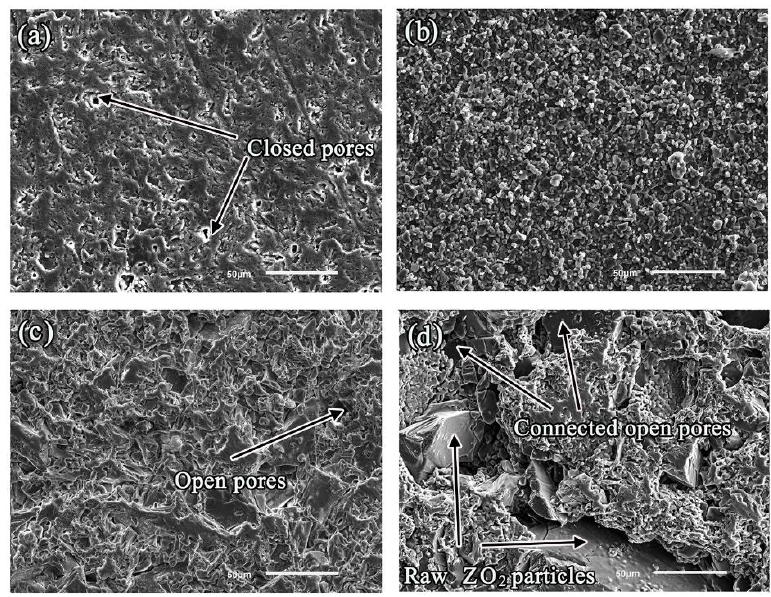
Figure 2. Microstructures of the various oxide ceramic substrates before sessile drop experiments: ( a ) MgO; ( b ) Y 2 O 3 ; ( c ) Al 2 O 3 ; and ( d ) ZrO 2 .